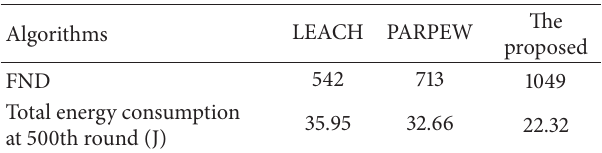
Figure 5: The relationship between the number of the survival nodes and the rounds. Table 2: The statistical average of lifetime and energy consumption of